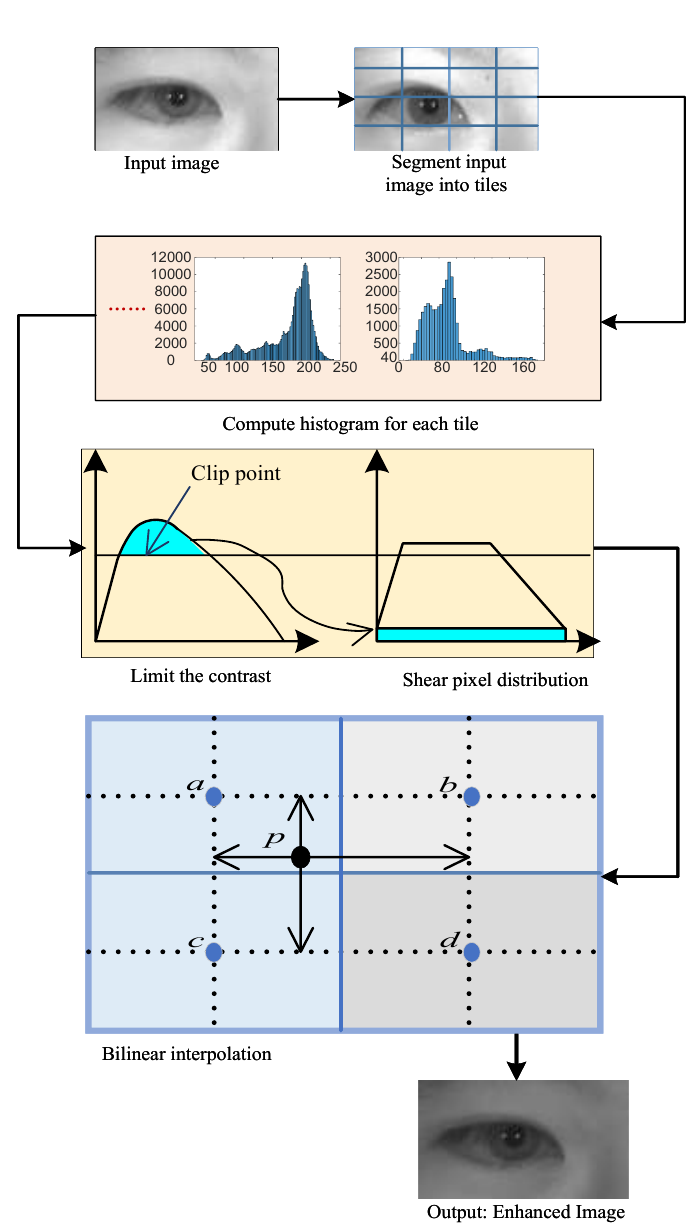
Figure 2. Flow chart of